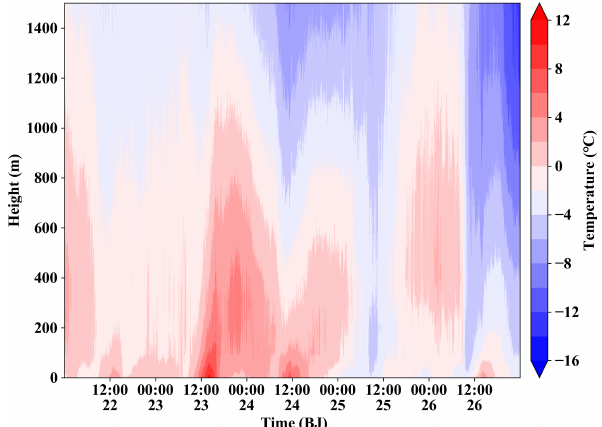
Figure 15. Vertical temperature profile of Beijing from 22 to 26 December 2015 in the Beijing observatory (39.93 ◦ N, 116.28 ◦ E) (unit: ◦ C).